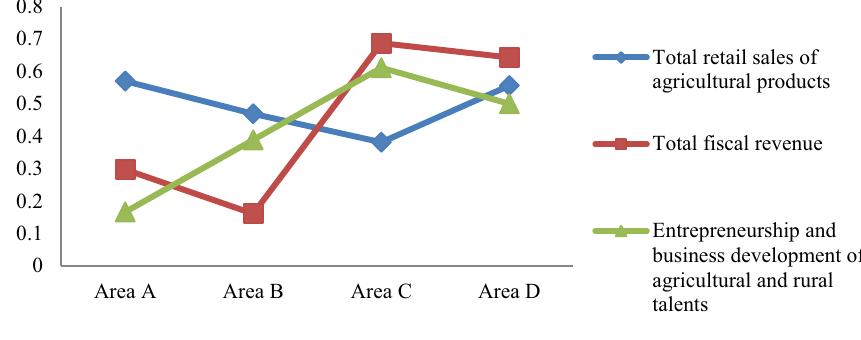
Fig. 3 Changes of the indicators under performance element vs. areas